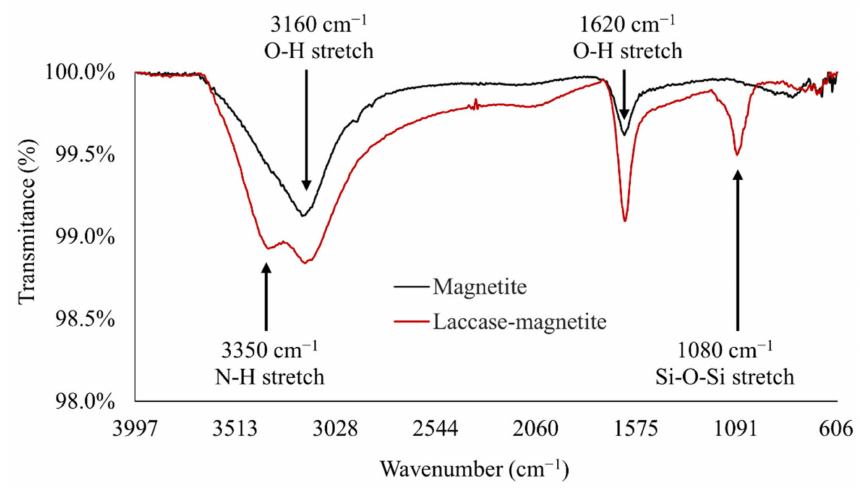
Figure 5. FTIR analysis of magnetite nanoparticles and Laccase-magnetite. The presence of peaks at 1620 and 3160 cm − 1 corresponds to the OH stretch from the magnetite surface. The presence of the peak at 1080 cm − 1 corresponds to the O-Si-O bond and corroborates effective silanization. The immobilization of laccase was confirmed by the presence of the amide I peak at around 3350 cm − 1